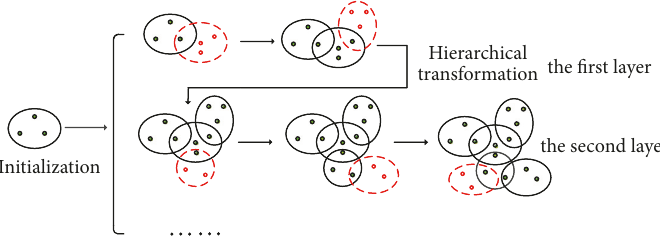
Figure 2: Hierarchical evolution process diagram of command and control